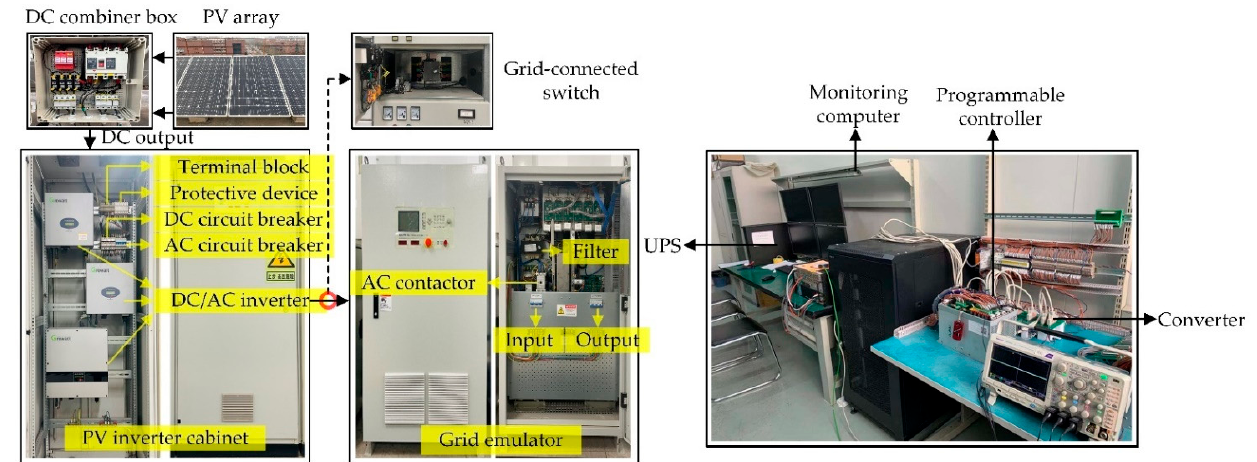
Figure 11. Experiment platform. Table 1. Experimental system parameters.